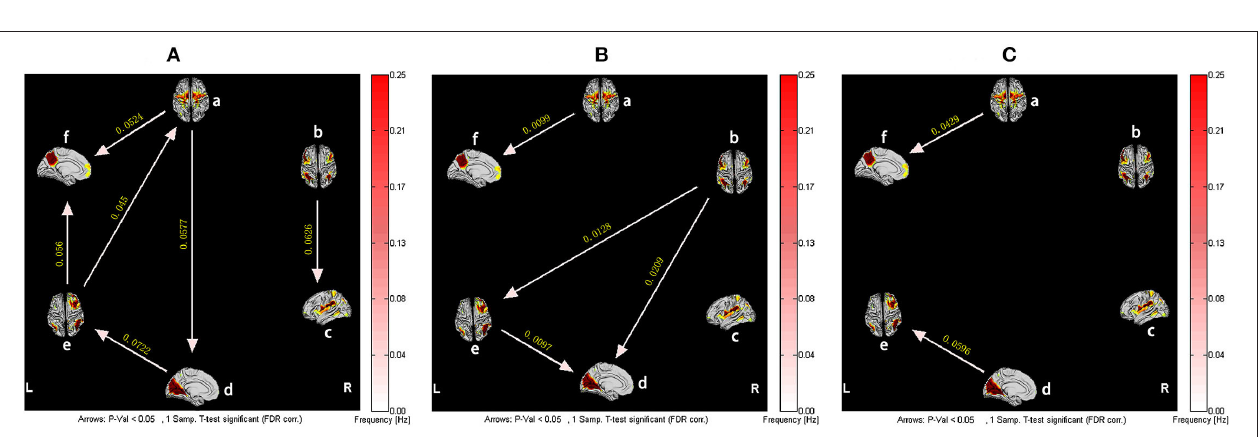
FIGURE 4 | The resting-state effective connectivity comparison of CFS patients before and after Tai Chi Chuan training. There are six resting-state networks, including: a, SMN; b, ECN; c, SN; d, VN; e, RFPN; f, DMN. Arrow directions represent causal effect between resting-state networks. Yellow numbers indicate strength of causality. Values on the color bar (corresponding with arrow colors) demonstrate frequency at which causality was found. (A) One-sample t -test result of intergroup intranetwork causal relationship of the CFS patients after Tai Chi Chuan training. (B) One-sample t -test result of intergroup intranetwork causal relationship of the CFS patients before Tai Chi Chuan training. (C) Paired t -test result of intragroup intranetwork causal relationship of after Tai Chi Chuan training minus before Tai Chi Chuan training for CFS